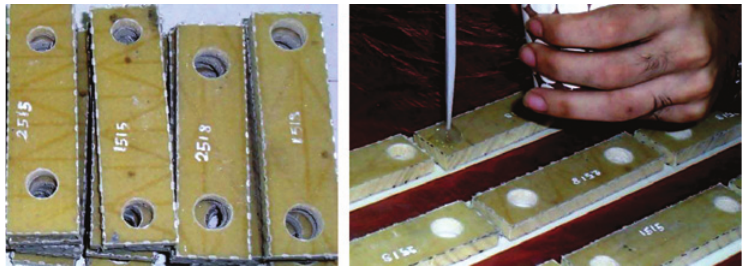
Figure 4 Preparation of the specimens with the potting